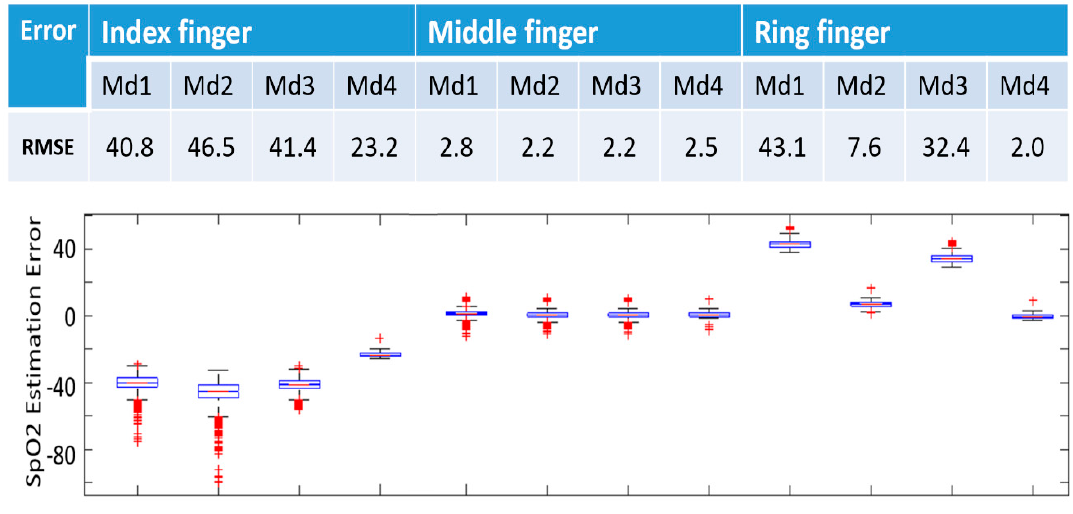
Figure 3. SpO2 model calibration of di ff erent finger types and SpO2 model types, showing that the middle finger type and the Md2 model are the best combination to calibrate the SpO2 model. RMSE: Root mean square error (%), Md1 / 2 / 3 / 4: Model based on first-order polynomial, second-order polynomial, third-order polynomial, and decision tree, respectively. Bar graphs represent 10, 25, 50, 75, and 90 percentiles of SpO2 estimation error. Md: Model.